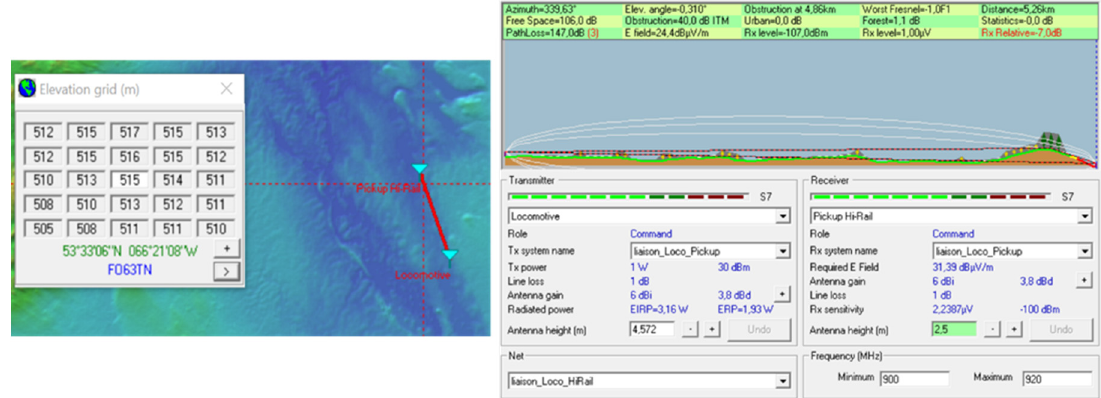
Figure 15. Negative budget link between Emeril (Labrador) and Schefferville (Quebec) on the railway.